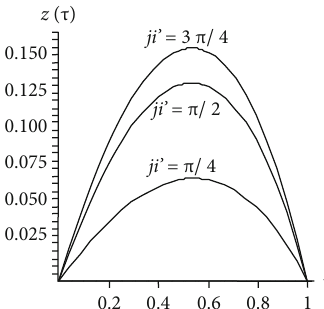
Figure 6: Velocity pro fi le for various values of ji ′ with q = 1 : 0 , N = 1 : 0 , R = 1 : 0 , and A = 1 : 0 .